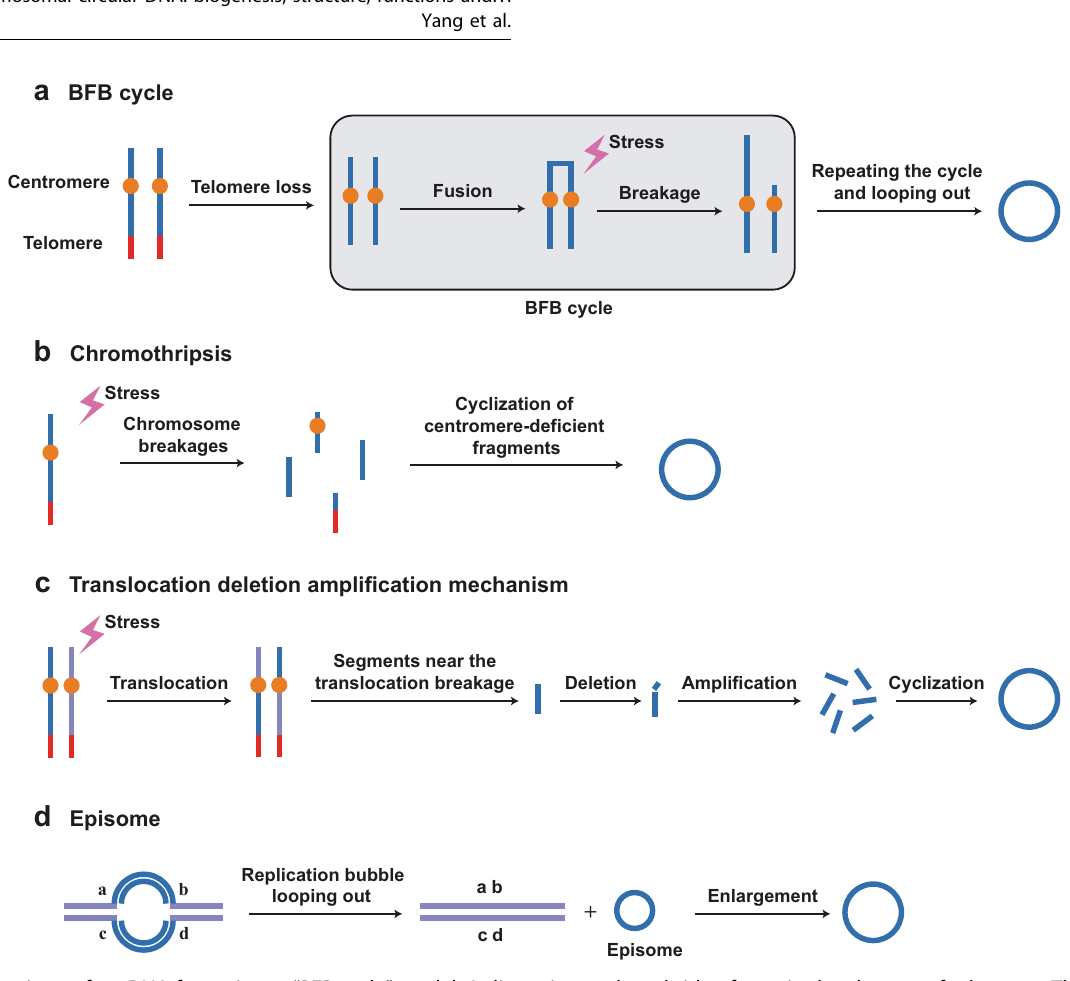
Fig. 2 Mechanisms of eccDNA formation. a “ BFB cycle ” model. A dicentric anaphase bridge forms in the absence of telomeres. The BFB cycle involves an anaphase bridge, followed by bridge breakage under stress, releasing eccDNA. b “ Chromothripsis ” model. Single- or double- stranded DNA breaks are formed under exogenous stress, and some of the fragments are ligated and circularized into eccDNA. c “ Translocation-deletion ampli fi cation ” model. Exogenous stimuli trigger chromosomal translocation. The DNA segments near the translocation breakpoints are ampli fi ed, deleted, and circularized to form ecDNA. d “ Episome ” model. Episomes are produced by DNA slippage and R-loops during the DNA synthesis process and are able to self-replicate and enlarge to form multimerized